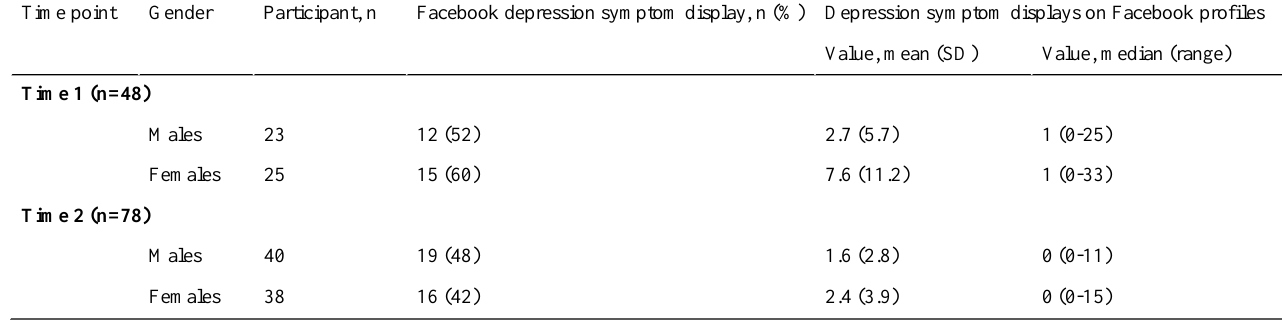
Table 3. Facebook depression symptom displays by gender at time 1 and time